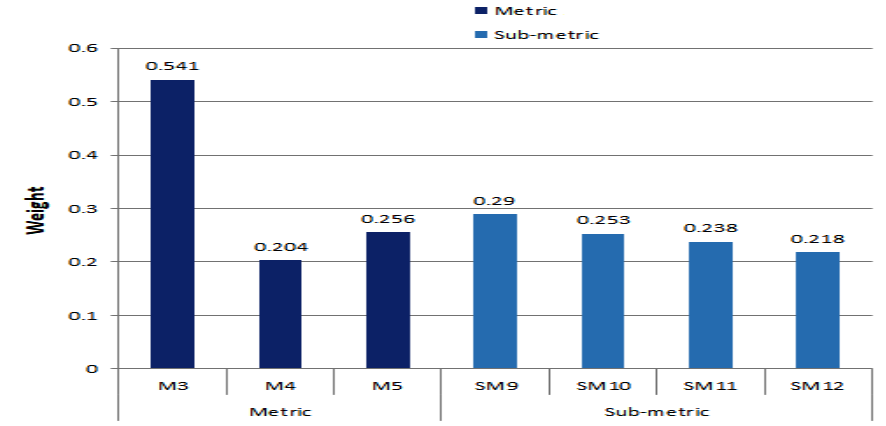
Figure 6. Ranking of Trust Metric for scenario 2.